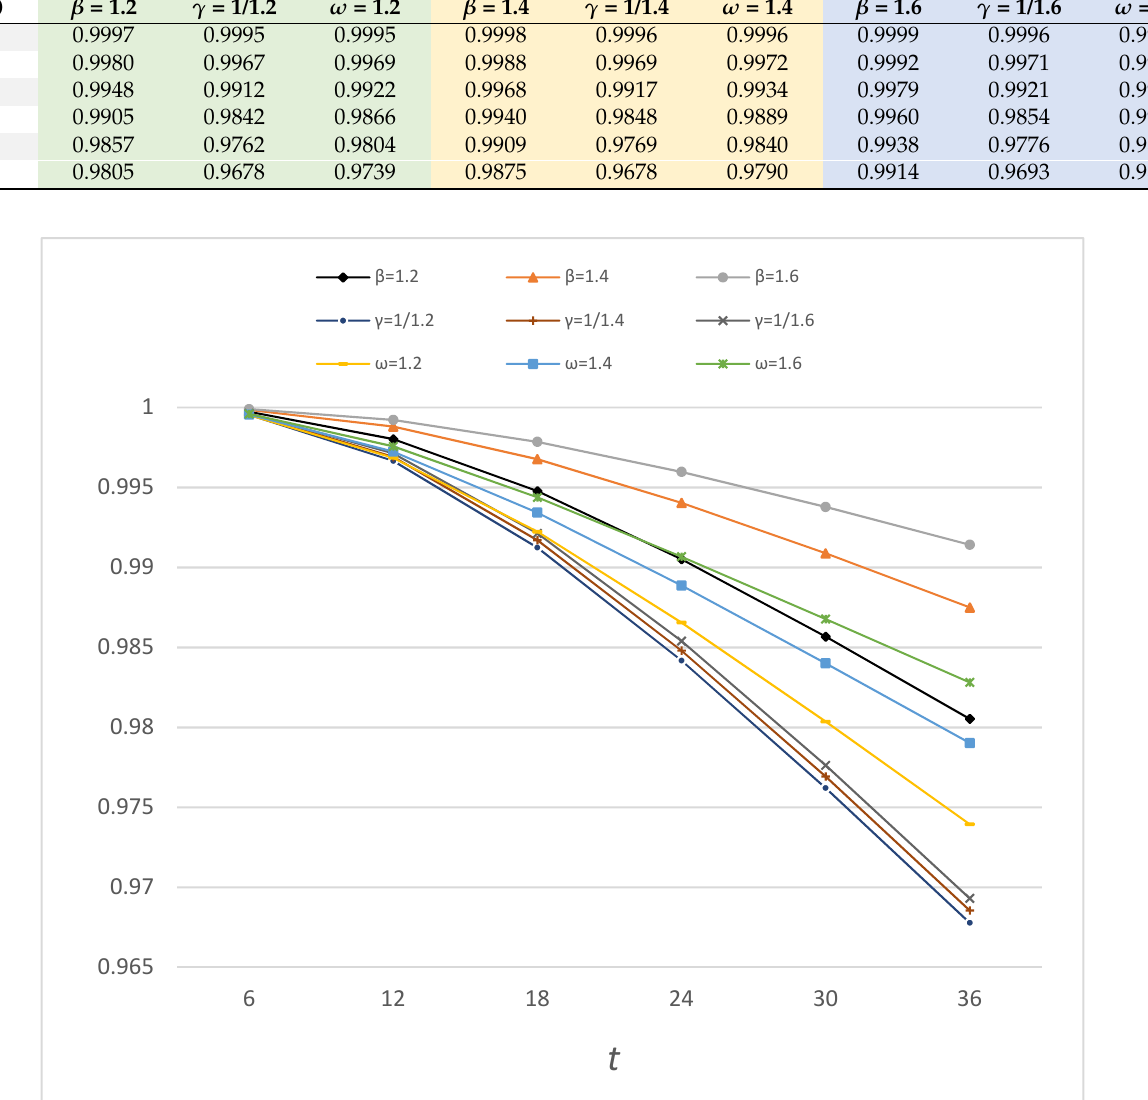
Table 8. Bitcoin dependability under the DDAA, ALP, and TM.